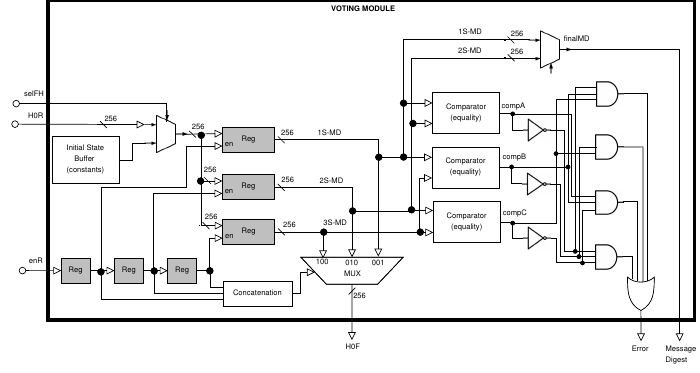
Figure 6. Block diagram of the Voting Module.